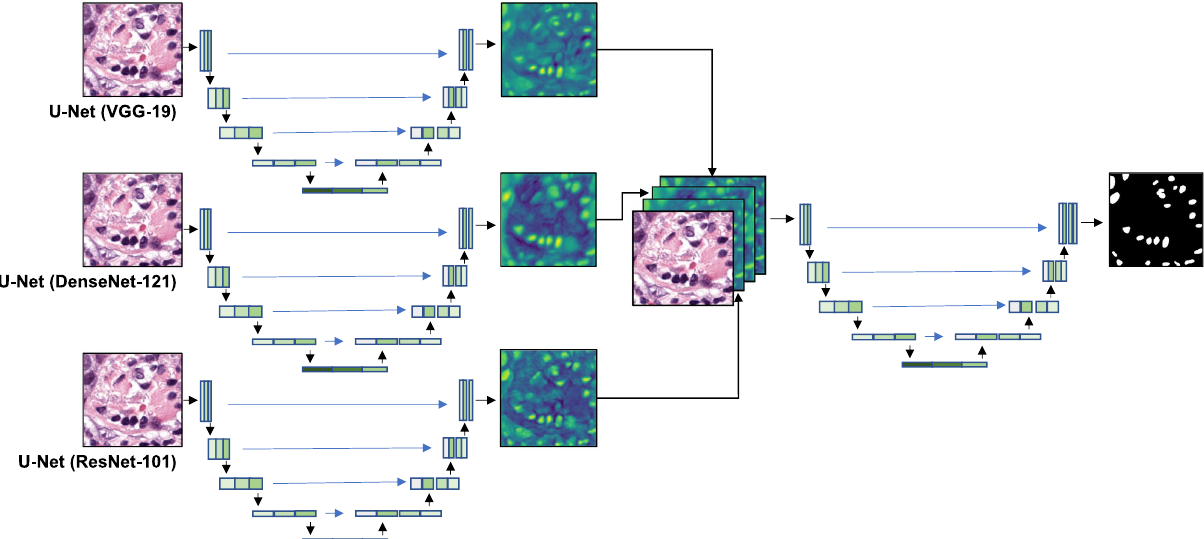
Figure 1. Network architecture of GB U-Net, a gradient boosting network. The first stage of GB U-Net concatenated features maps from three U-Net like DCNN (VGG-19, DenseNet-121, and ResNet-101 encoders), with the colour normalized H&E image. The second stage of GB U-Net passed the concatenated image through a final U-Net. The original H&E images were curated by the TCGA. Ground truth annotations were released by Kumar et al. 16 , and additional annotations were released during the MoNuSeg